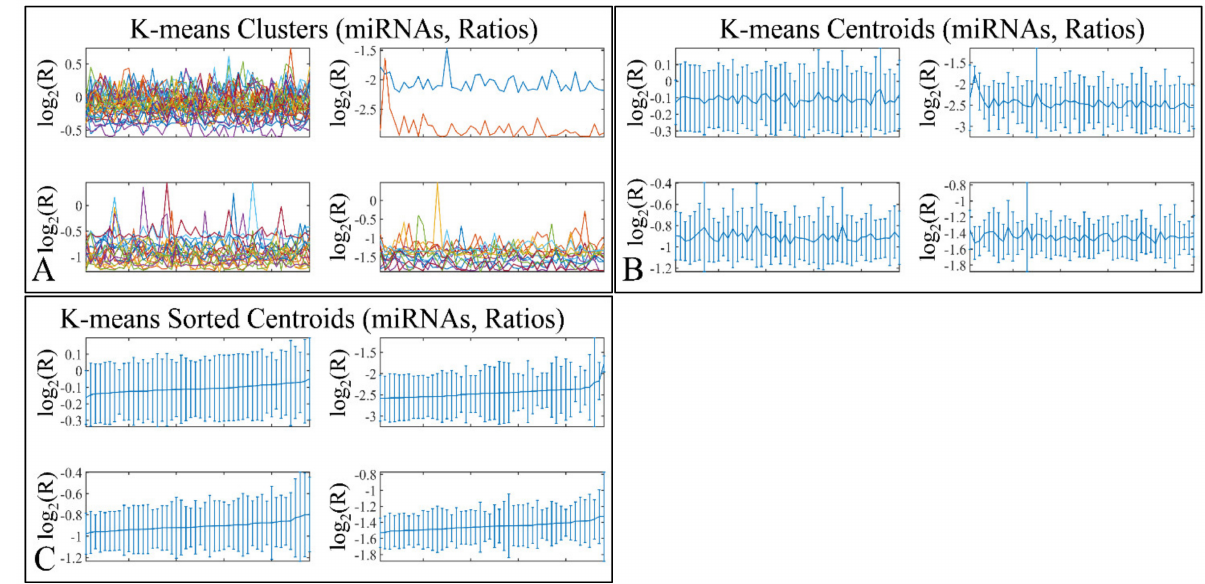
Figure 11. K-means clustering of DE miRNAs. K-means clustering manifested four clusters ( A ), which is presented with the respective centroids ( B ), and sorted centroids ( C ). K-means clusters did not manifest any distinct patterns of expression.